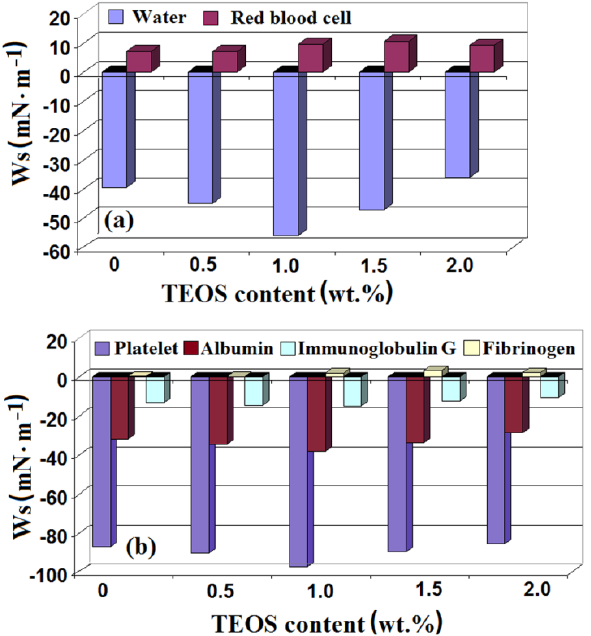
Figure 12. Work of spreading of ( a ) water, red blood cells, ( b ) platelets, and plasma proteins versus TEOS content for cellulose acetate/silica films.